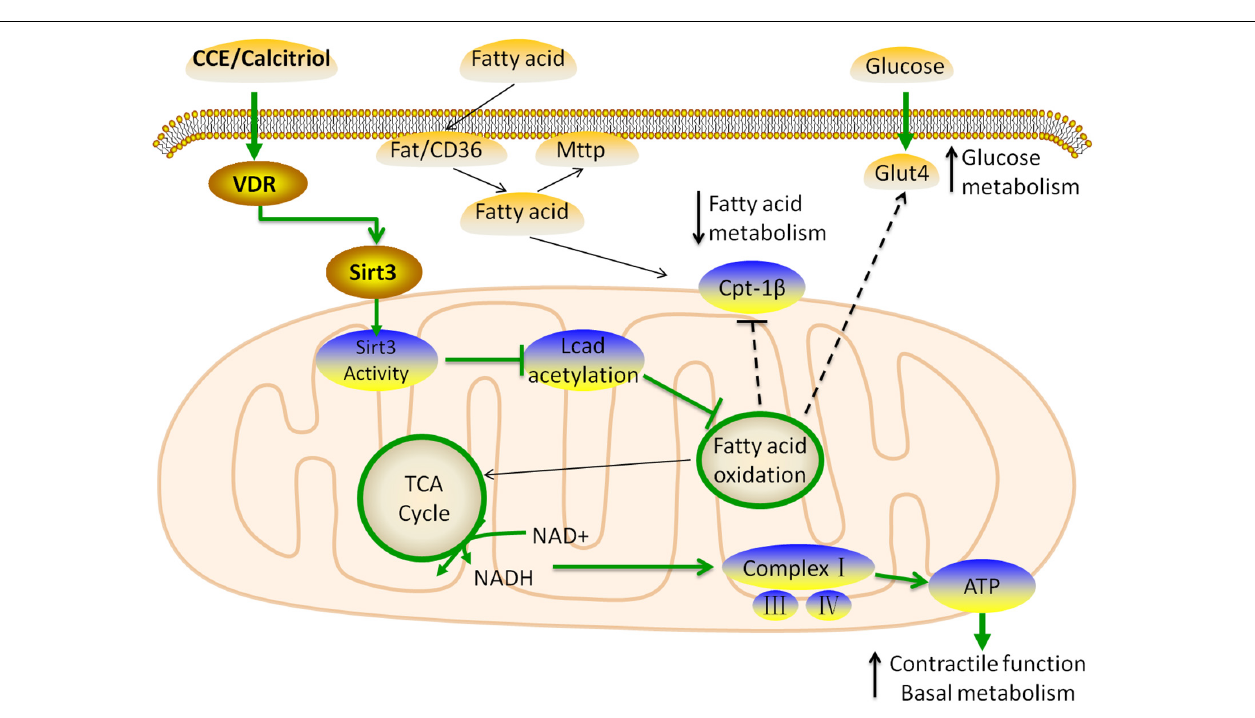
FIGURE 8 | Schematic model for the role of vitamin D in the regulation of cardiac fatty acid metabolism. The VDR activated by CCE and calcitriol upregulated the expression of Sirt3 through transcriptional regulation. SIRT3 inhibits the expression of LCAD and stimulates that of mitochondrial complexes through the use of common substrate NAD + , resulting in decreased fatty acid β -oxidation. VDR does not affect the inflow (Fat/CD36) and outflow (MTTP) of fatty acids, and ultimately suppresses CPT-1 β to reduce the uptake of fatty acids in the mitochondria. In addition, to balance energy substrate use, VDR upregulates GLUT4, thus, promoting glucose metabolism. These changes lead to a balance of glucose and fatty acid metabolism in myocardial cells, which is beneficial to myocardial